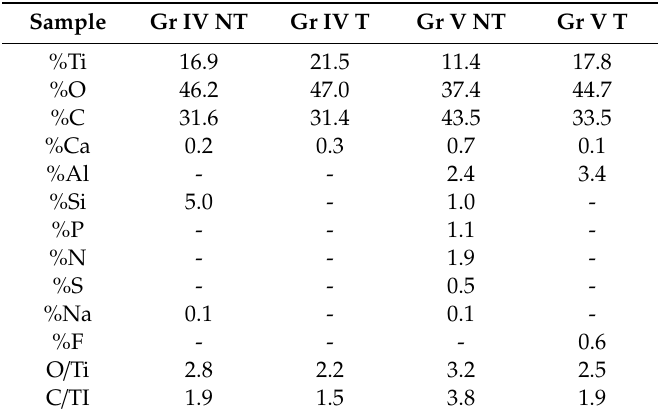
Figure 4. O 1s XPS spectra of the untreated grade V ( a ) and the treated grade V surfaces ( b ). C1s spectra of the untreated grade V ( c ) and the treated grade V ( d ) surfaces. (GR IV: Titanium grade IV; GR V: Titanium grade V; T: SLA treated; NT: SLA non-treated). Table 2. Surface atomic percentages determined by XPS found in the non-TiO 2 -coated samples. Sections (c) and (d) show the carbon region, where species of hydrocarbon (CH X ), carbon oxides (CO x ), carboxylates (CO 2 − ) are observed and, only in sample c), titanium carbide (TiC), were studied.